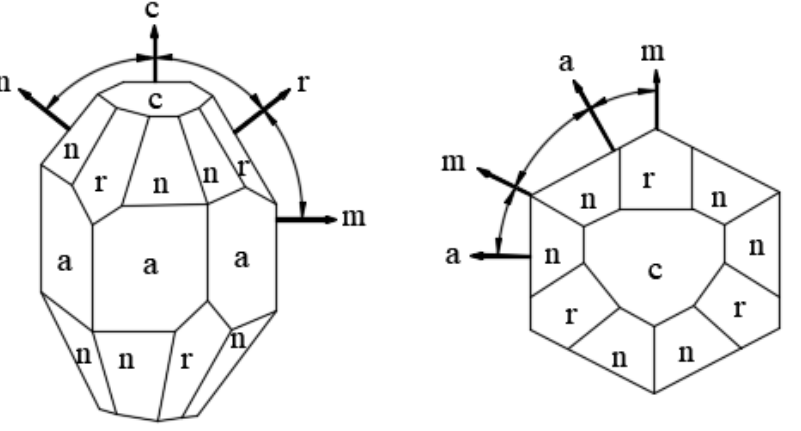
Figure 3. Different crystal planes of sapphire single crystal.